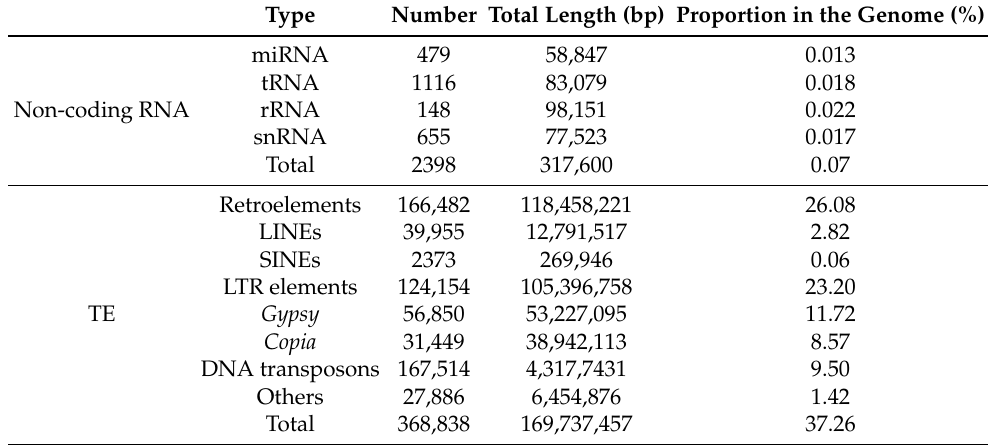
Table 1. Statistics of Non-coding RNAs and TE sequences. Type Number Total Length (bp) Proportion in the Genome